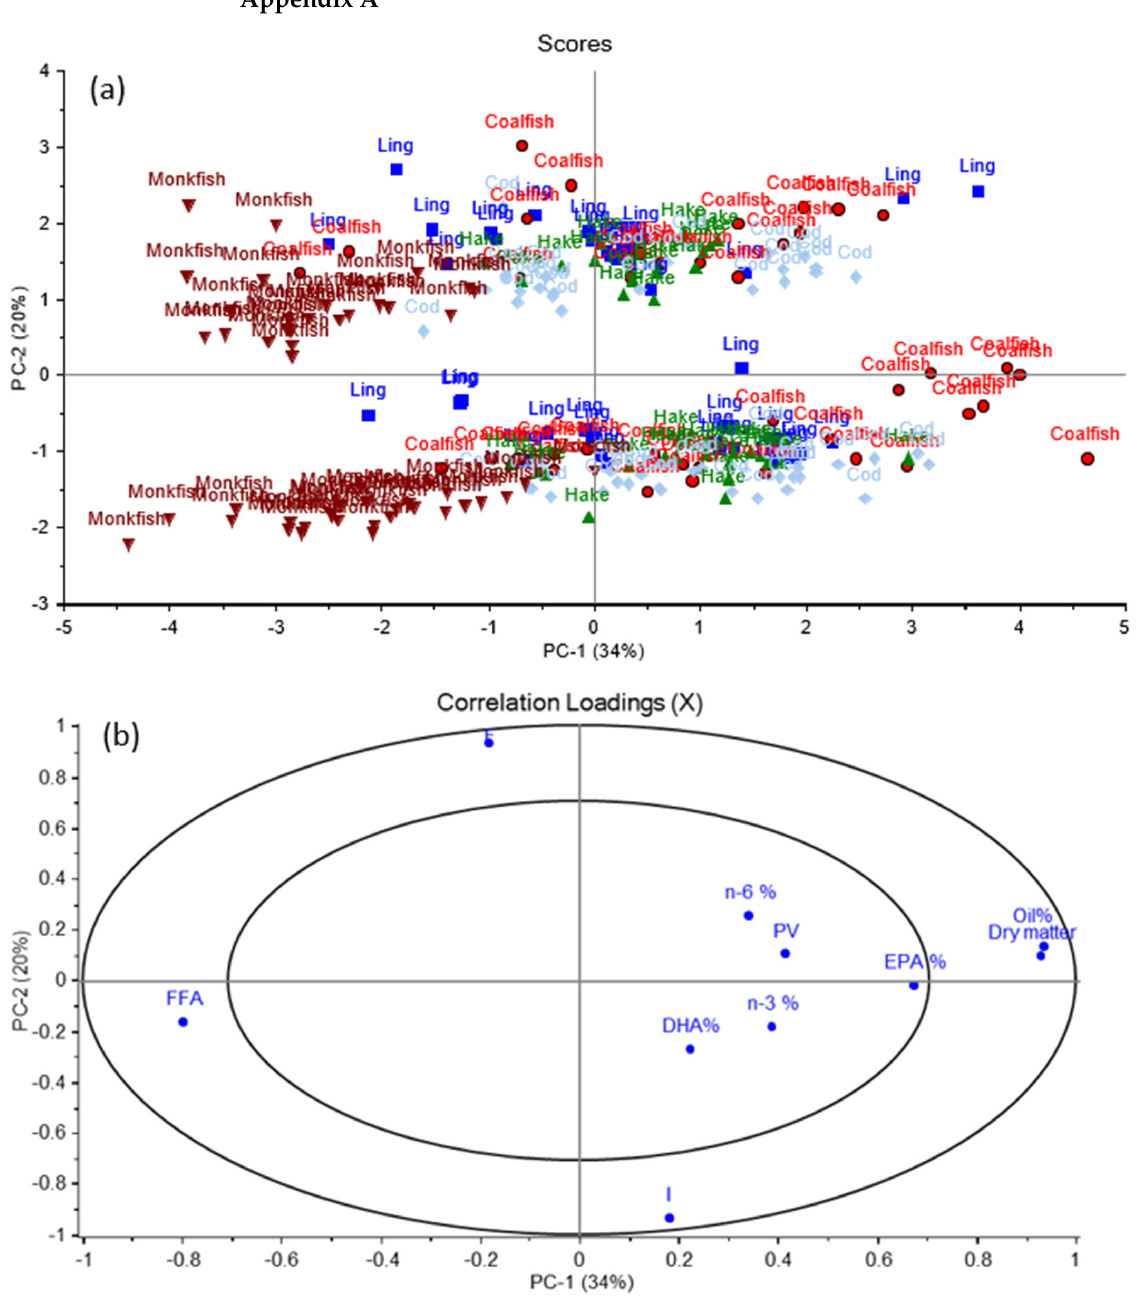
Figure A1. Results from PCA of all samples and their oil content, dry matter, total n-3 PUFA %, total n-6 PUFA %, EPA %, DHA %, PV, FFA and information on storage conditions. ( a ) Scores plot, ( b ) Loadings plot. In loadings plot: I Ice storage, F Frozen